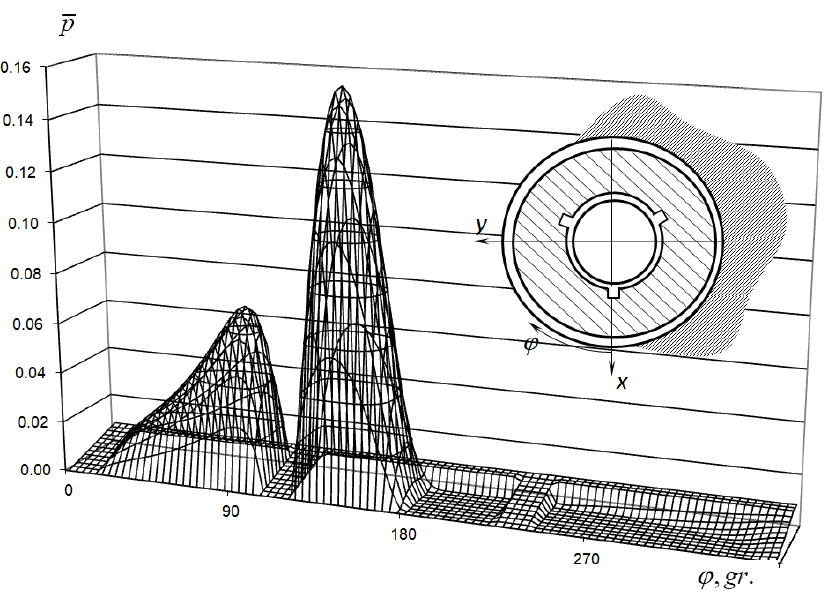
Figure 8. Diagram of hydrodynamic pressures in the lubricating layer with three longitudinal grooves.